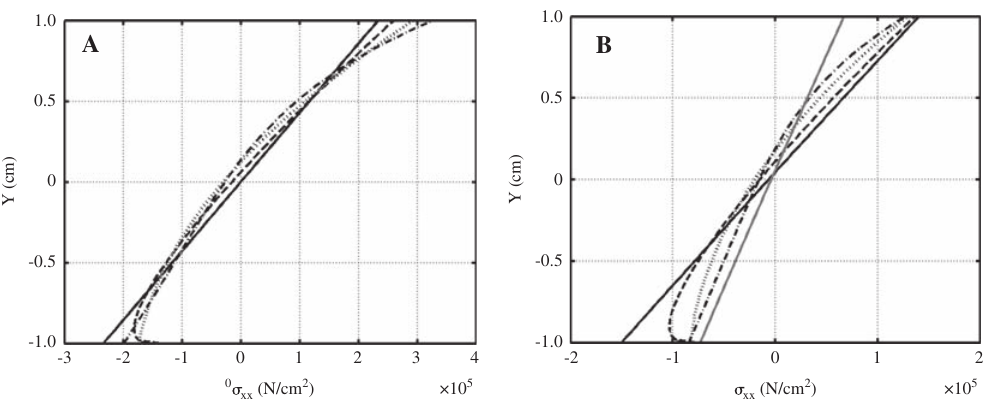
Figure 11 (A) Normal stress distributions in the geometrically linear case. (B) Cauchy normal stress distributions for various values of the power-law exponent at midpoint of the beam for q = 500 N/cm 2 . ( – – – – ) Full ceramic, ( – – – ) k = 0.3, (------) k = 1, ( – – – ) k = 3, ( – – – – ) full metal.